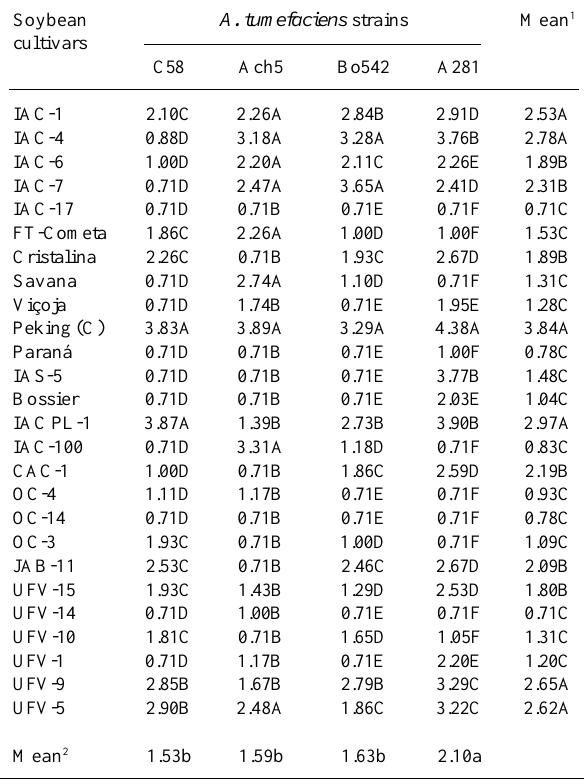
Table II - Mean number of galls (x + 0.5) 1/2 in each soybean cultivar produced by Agrobacterium tumefaciens strains. Soybean